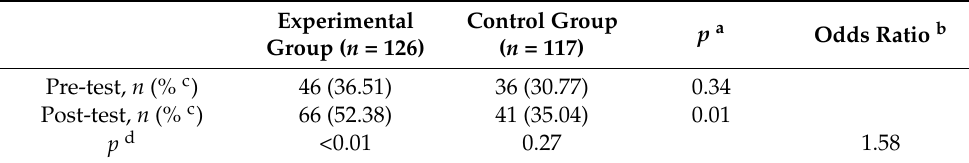
Table 3. The pre- and post-test proportions of pregnant women who were willing to be vaccinated between both groups.